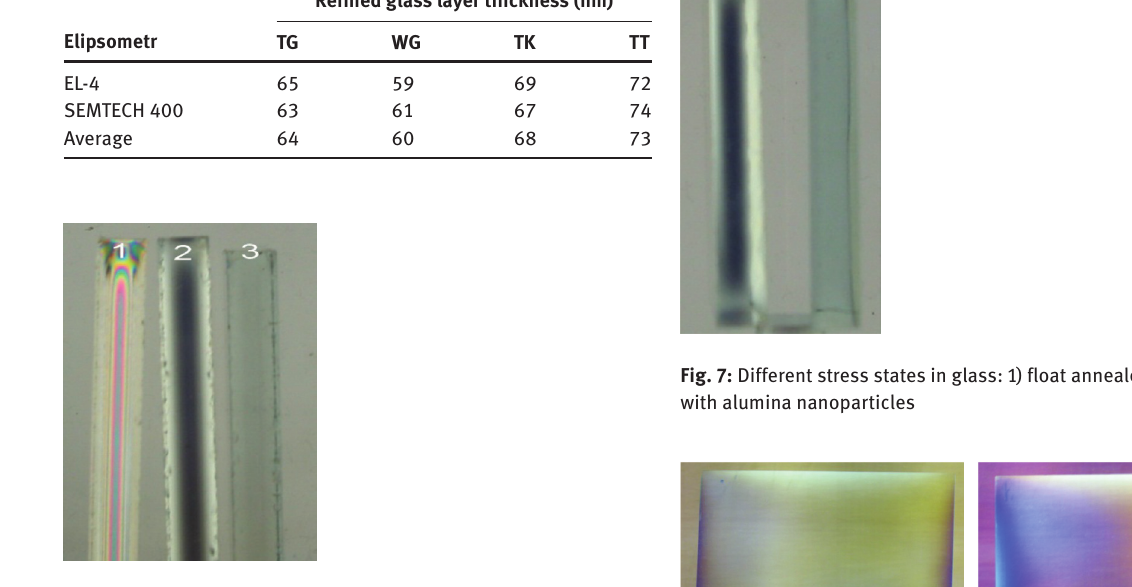
Fig. 6: Different stress states in the glass with polariscope optical axes crossed: 1) float tempered glass, 2) annealed float glass, 3) optical glass